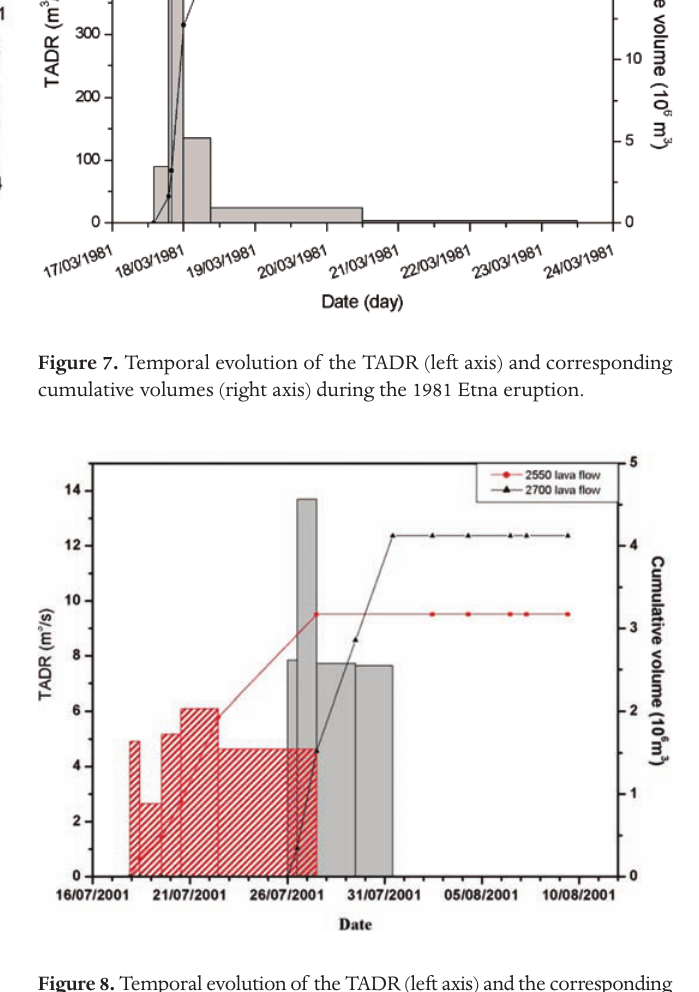
Figure 6. Lava flow thickness distribution of the 2001 Etna eruption from the 2,700 m and 2,550 m a.s.l. vents. Black lines, position of the 13 earth barriers built during the eruption.